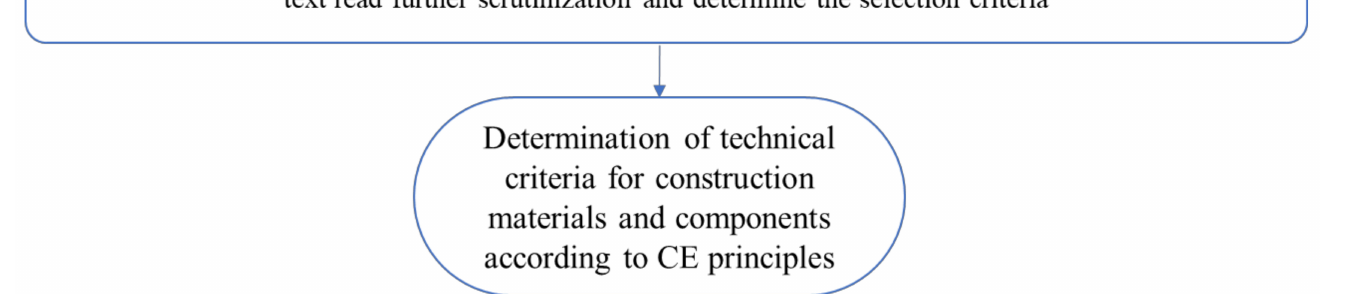
Figure 1. The methodology of the